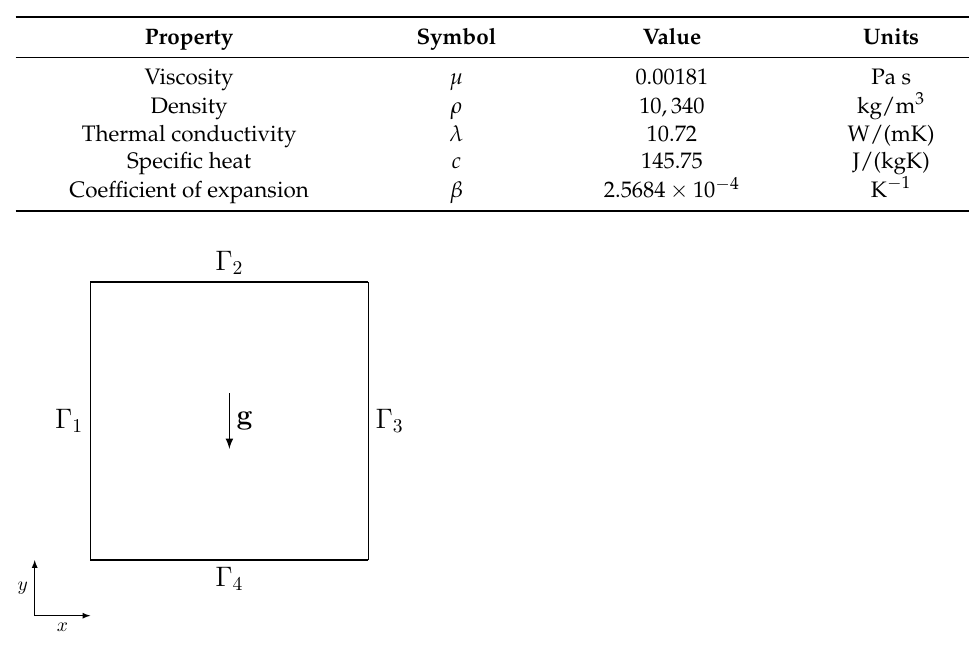
Figure 1. Computational domain for the optimal control of Boussinesq equations, where g is the gravity vector and Γ 1 , Γ 2 , Γ 3 , and Γ 4 are the boundaries.